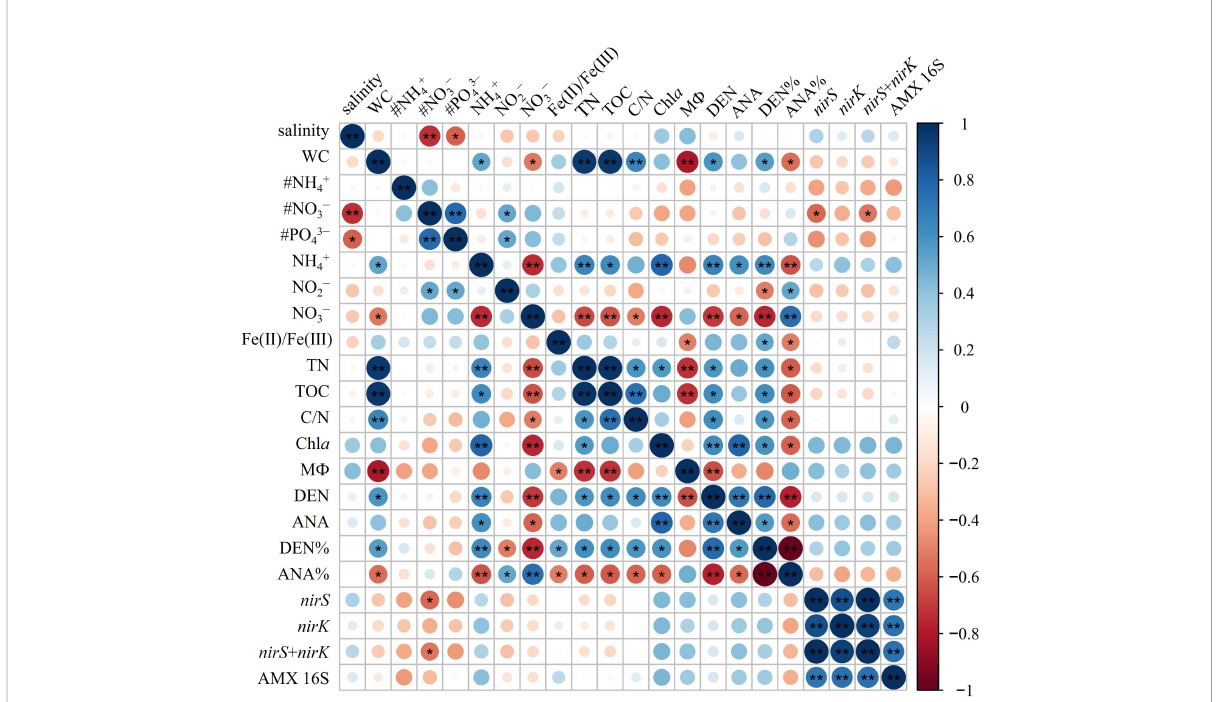
FIGURE 4 Pearson ’ s correlations of environmental factors with the denitri fi cation/anammox and related gene abundances. * signi fi cant at p < 0.05, ** signi fi cant at p < 0.01. # represents bottom water parameter (# NH 4 − , # PO 3 − , # PO 43 − ). WC, water content; Chl a , Chlorophyll a; DEN, denitri fi cation rates; ANA, anammox rates; DEN%, the contribution of denitri fi cation to N removal; ANA%, the contribution of anammox to N